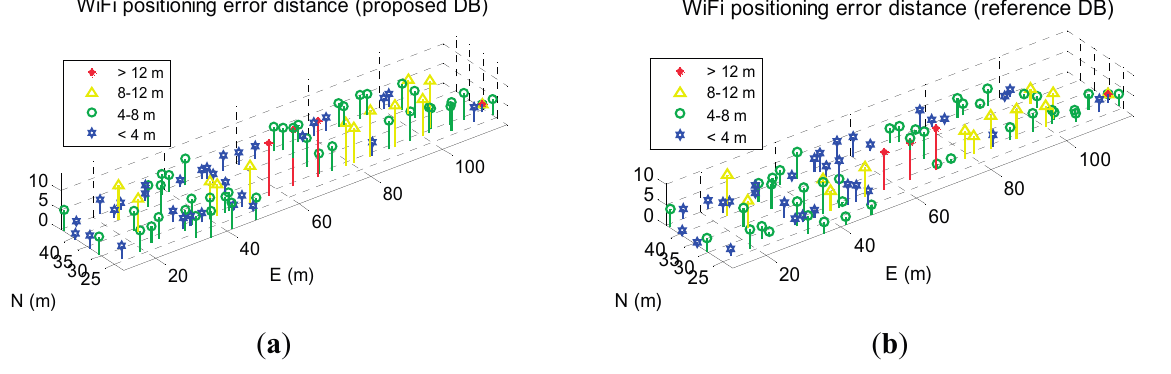
Figure 11. WiFi fingerprinting error distribution when using proposed DB ( a ) and using reference DB ( b ).